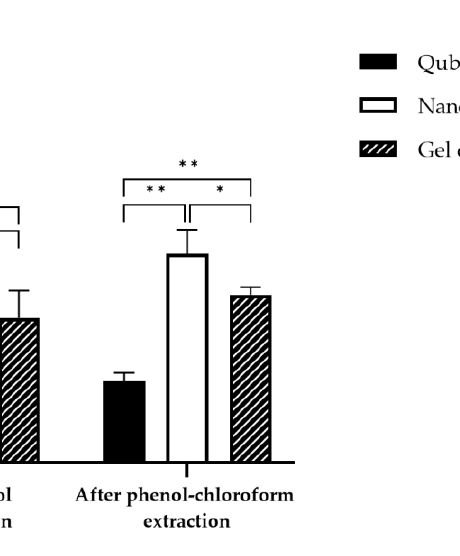
Figure 7. Histogram of ssDNA recovery quantified by Qubit, Nanodrop or gel quantification for purification of ssDNA using streptavidin-coated beads before and after two types of purification. The three ssDNA quantification techniques were compared in a peer comparison by Student’s statistical test. Asterisks represent significant differences according to Student’s t test (*: threshold of 0.01 or **: threshold of 0.001).